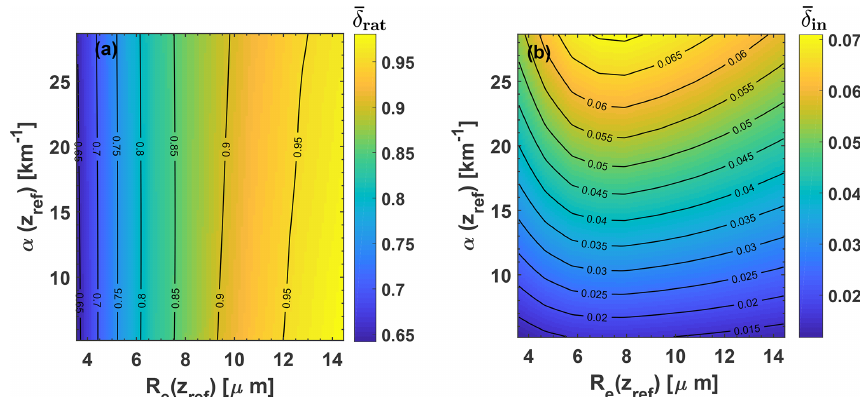
Figure 6. (a) Ratio δ rat (z bot ,z ref ) of depolarization ratios (see Eq. (25), integration height range of (cid:49)z ref = 75m) as a function of droplet effective radius R e (z ref ) and cloud extinction coefficient α(z ref ) . Cloud base z bot is at 3km height, z ref is thus at 3.075km height. (b) Inte- grated depolarization ratio δ in (z bot ,z ref ) as a function of R e (z ref ) and α(z ref ) . Isolines of δ rat in (a) show the strong dependence of δ rat on the effective radius. The δ in isolines in (b) highlight the dominating influence of the extinction coefficient on δ in . The figures are based on 720 simulated cloud scenarios for each of the FOVs of 1 and 2mrad.